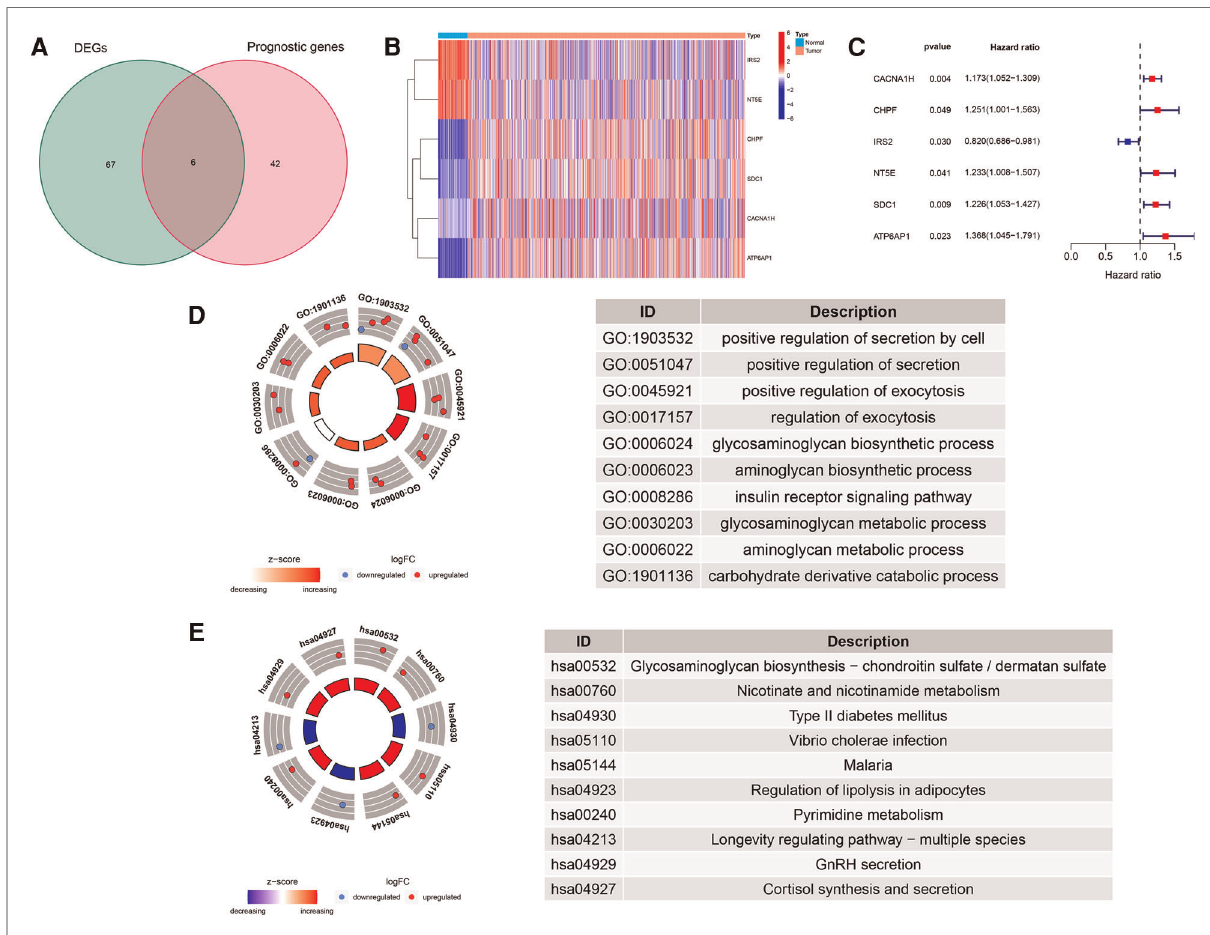
FIGURE 2 Identi fi cation of GRG candidates in TCGA cohort. ( A ) Venn diagrams of DEGs and Prognostic genes. ( B ) The expression pattern of GRG candidates. ( C ) Univariate Cox regression analysis of GRG candidates. ( D ) GO enrichment of GRG candidates. ( E ) KEGG enrichment of GRG